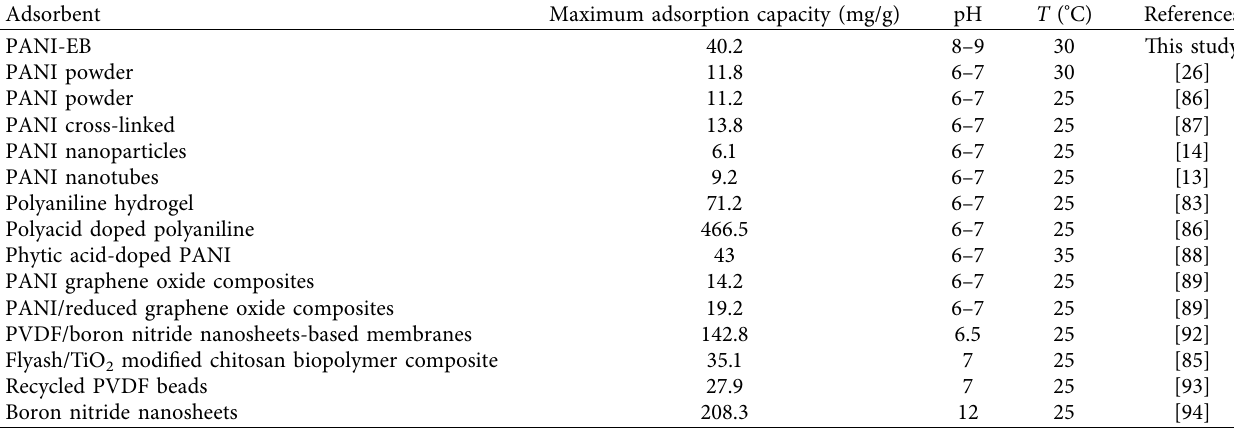
Table 7: Maximum MB adsorption capacities reported for various PANI-based adsorbents and other materials.